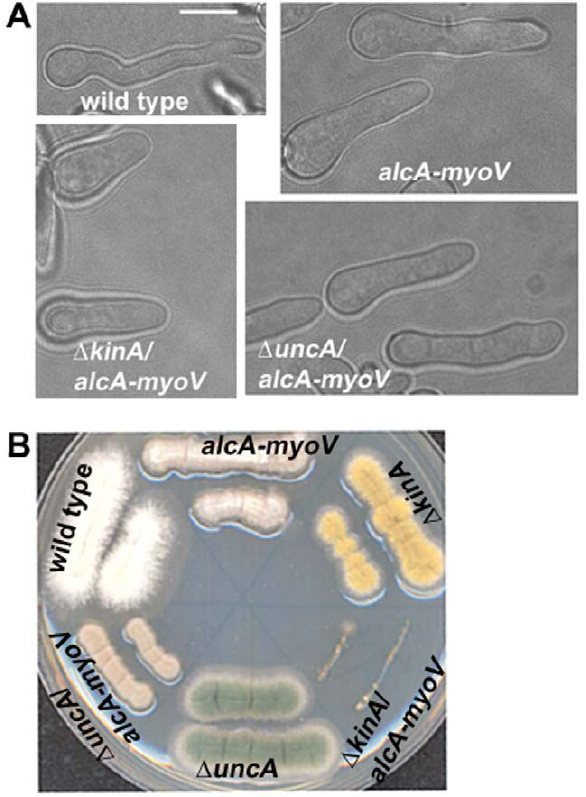
Figure 5. The D kinA/ D uncA / D uncB / alcA-myoV quadruple mutant exhibits a severe polarity defect when grown on the repressive YUU medium. (A) The quadruple mutant failed to grow on a YUU plate. (B) In YUU liquid culture, the quadruple mutant failed to undergo polarized hyphal growth after an eight-hour incubation at 37 u C. An arrow head points to a spore that had not undergone germination, thus indicating that mutant cells had undergone isotropic growth. (C) After an overnight incubation at 32 u C, cells were highly abnormal in shape, and leakage of cell contents could be seen (arrows). An image of DAPI staining is included to demonstrate the presence of multiple nuclei. All panels shown are at the same magnification. Bar, 5 m m.